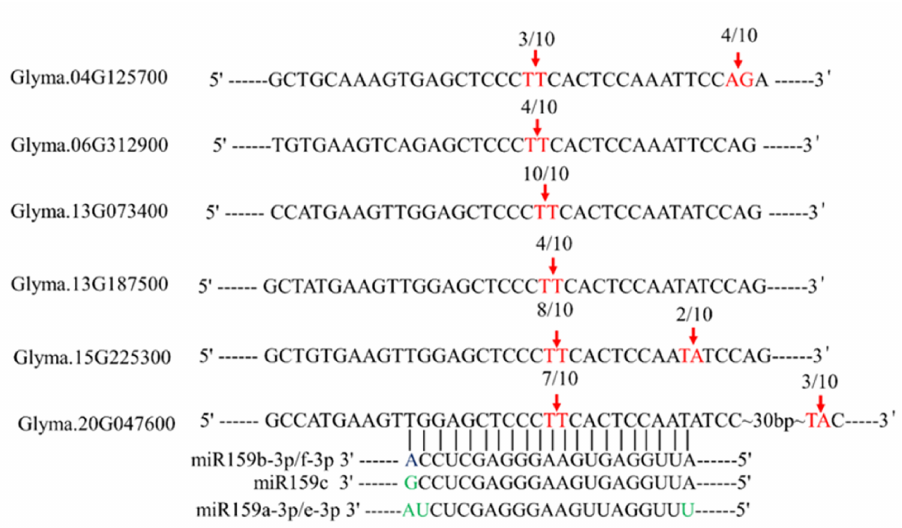
Figure 2. Validation of the cleavage sites of miR159 target genes. The soybean mature miR159 sequences were placed into psRNATarget (http://plantgrn.noble.org/psRNAtarget/, accessed on 1 February 2020) to predict their target genes and cleavage sites with default parameters, followed with a 5 (cid:48) -RACE PCR experiments that were conducted to confirm the cleavage sites of miR159. Ten different clones for each target gene 5 (cid:48) -RACE PCR products were analyzed by DNA sequencing. The cleavage positions were highlighted with red arrows, the cleavage frequency is shown above and the characters in green colour indicate different nucleotides of mature miR159 sequences.